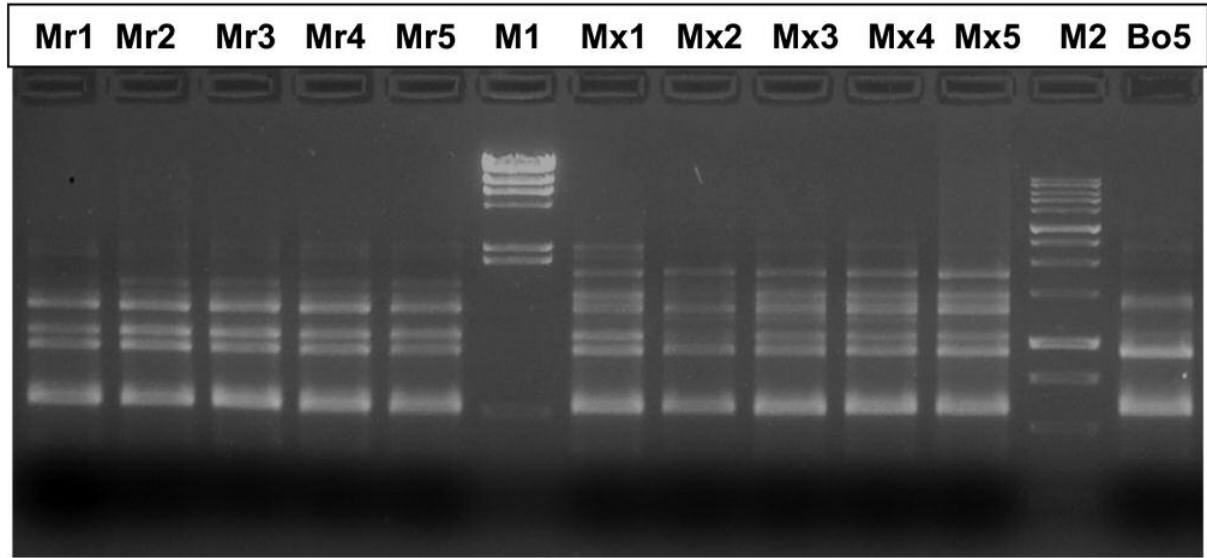
Figure 2 Comparative RAPD amplification profiles of individual plants belonging to “Maroulitis” (Mr1 to Mr5; 5 samples), “Mavroschinos” (Mx1 to Mx5; 5 samples) and “Votomos” (Bo5; 1 sample) using primer OPG2 and a hot-start procedure. Samples were electrophoresed in a 1.8% agarose gel (1X TAE buffer). Lanes: M1, DNA λ / Hind III. M2, 1.0 kb- DNA